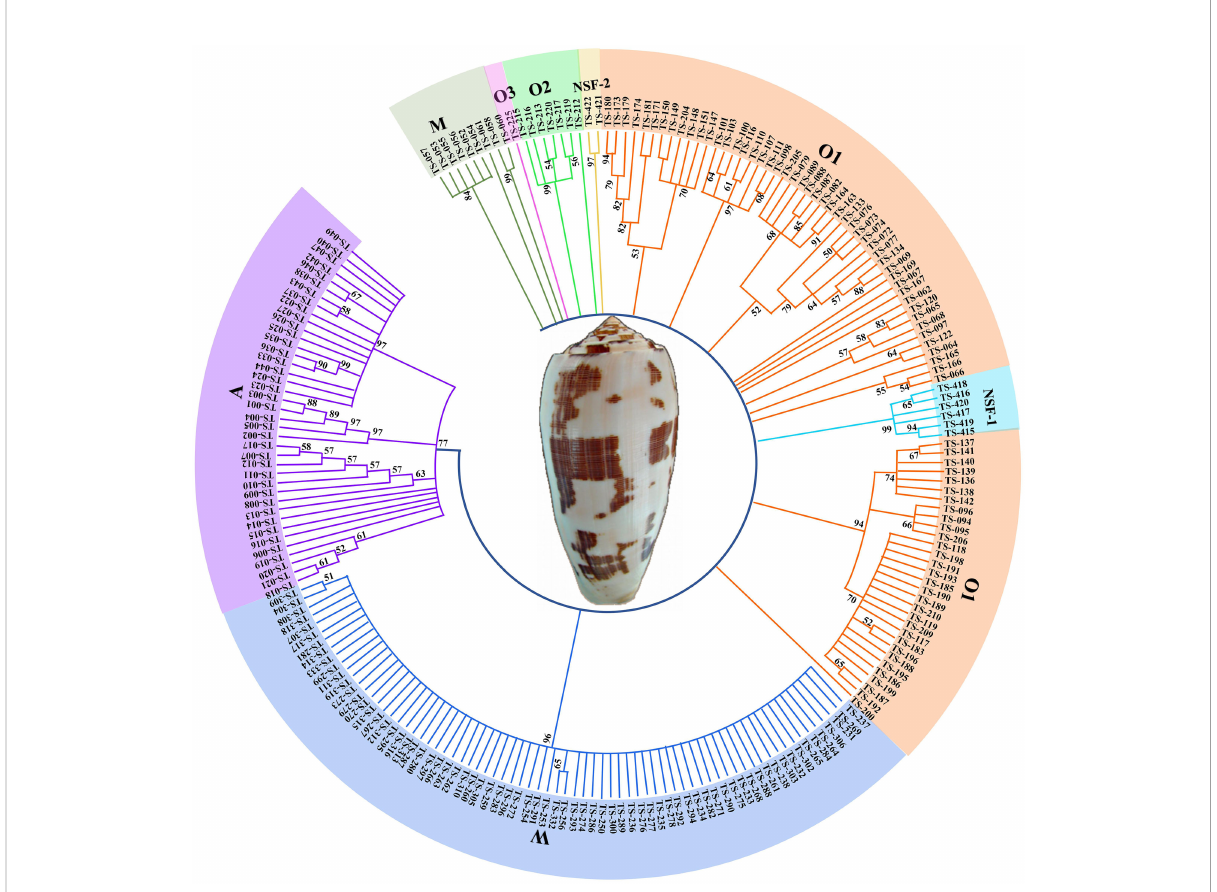
FIGURE 5 Phylogenetic tree of 216 complete sequences in A, O, M, W and New superfamilies. The amino acid sequences were aligned and a guide tree was constructed using the ClustalW 2.1. Tree building method: Maximum